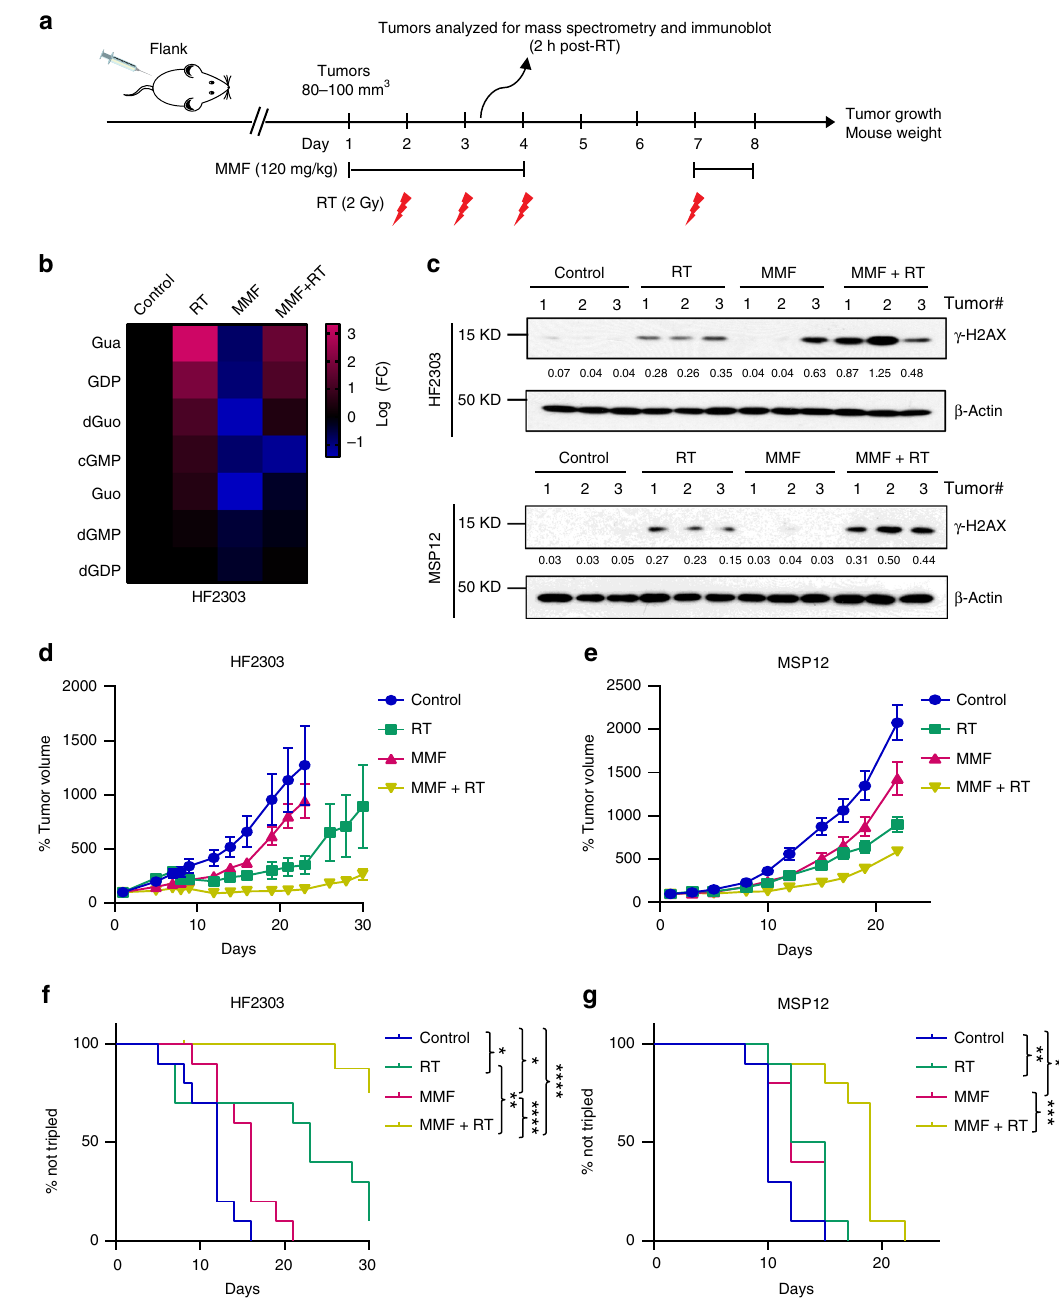
Fig. 6 MMF augments RT ef fi cacy against immortalized GBM xenografts. a A schematic timeline of HF2303 and MSP12 fl ank models. HF2303 and MSP12 xenograft GBM models were established and randomized as described in “ Methods ” . Mycophenolate mofetil (MMF) (120 mg/kg) was administered via oral gavage once daily beginning the day prior to RT and ending the day after. MMF was given 2 h before RT and held on weekends (six total doses). RT (2 Gy/fraction) was administered over four daily fractions on weekdays. b , c A subset of tumors harvested 2 h after receiving the second RT dose were analyzed by LC-MS/MS ( b ), or were ground and lysed for immunoblotting assay with indicated antibodies. The bands were quanti fi ed using Image J 2.0 software and the quanti fi ed numbers were labeled under each band ( c ). Fig. c are representative fi gures from three biologically independent experiments. d , e Tumor volumes for the indicated treatment groups are normalized to the individual tumor sizes de fi ned on day 1. Error bars indicate mean ± SEM from ten tumors of 5 mice per group. f, g Kaplan – Meier estimates of time to tumor tripling. p values for Control vs. RT are 0.0117 Fig. f and 0.0089 Fig. g ; Control vs. MMF are 0.0133 Fig. f and 0.0324 Fig. g ; Control vs. MMF + RT are <0.0001 Fig. f , g ; RT vs. MMF + RT are 0.0026 Fig. f and 0.0009 Fig. g ; MMF vs. MMF + RT are <0.0001 Fig. f and 0.0006 Fig. g ; * p < 0.05; ** p < 0.01; *** p < 0.001; **** p < 0.0001. The p values were obtained by the log-rank (Mantel – Cox) test. Source data are provided as a Source Data fi